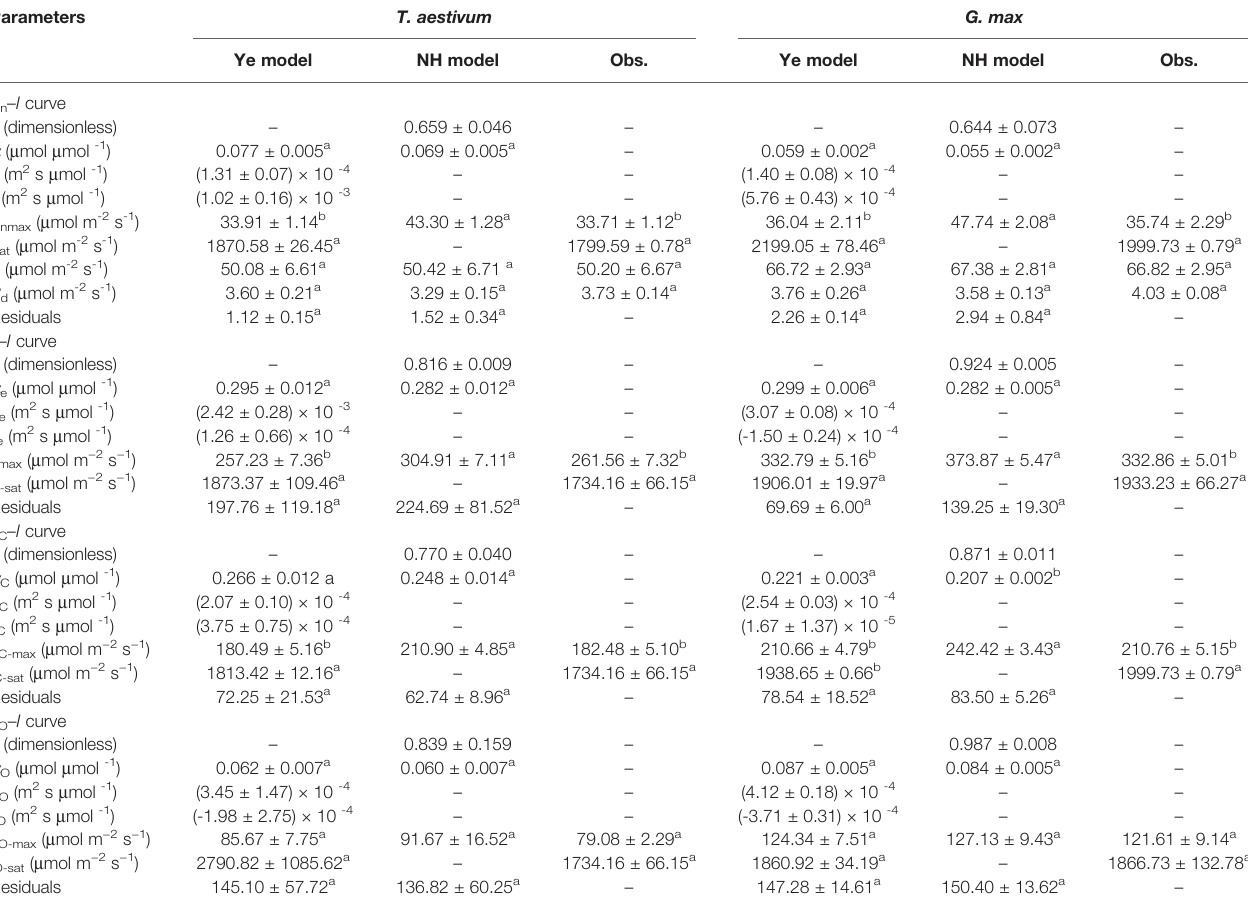
TABLE 1 | Fitted (Ye model and NH model) and measured values (Obs.) of parameters de fi ning the light-response curve of photosynthesis ( A n – I curve), electron transport rate ( J – I curve), electron transport rate for RuBP carboxylation ( J C – I curve), and electron transport rate for RuBP oxygenation ( J O – I curve) for wheat and soybean species,